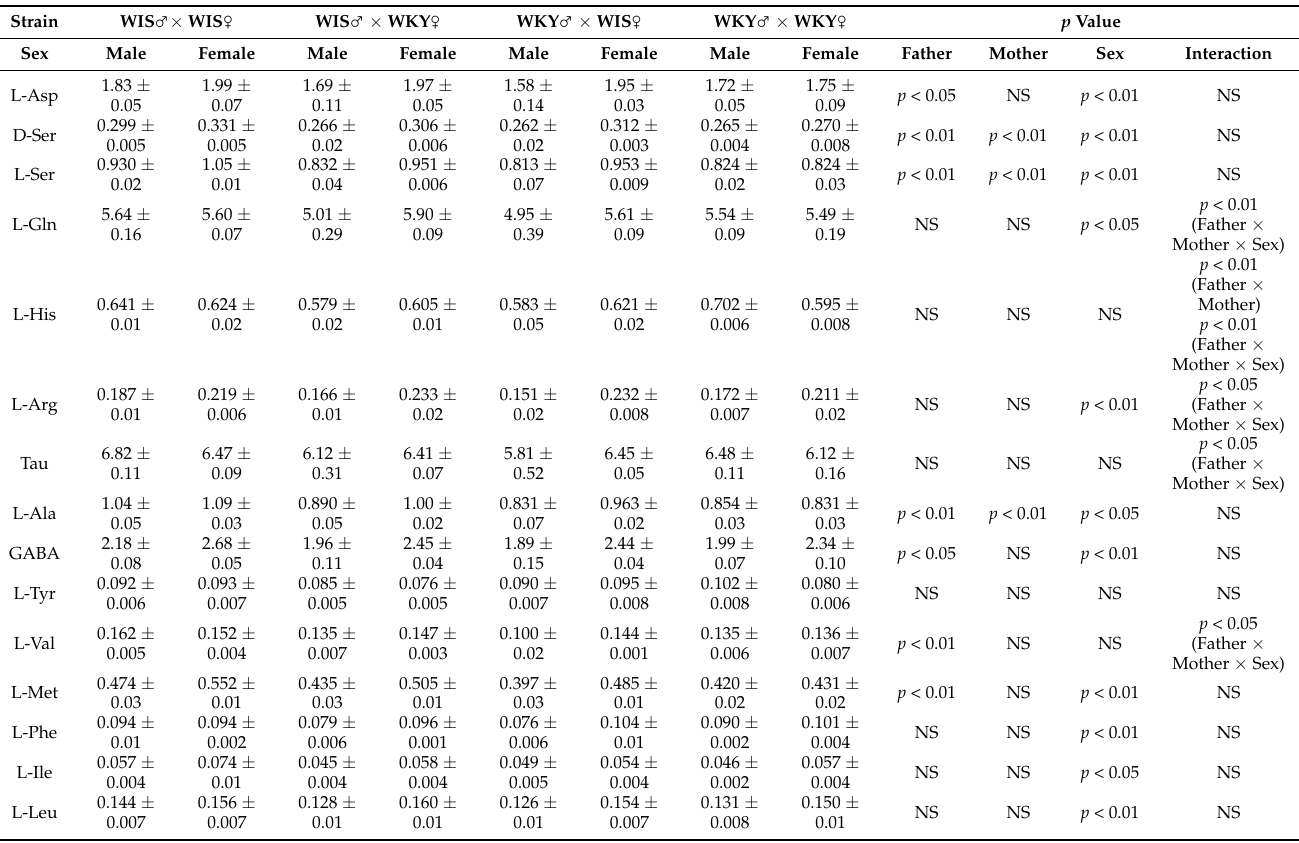
Table 2. Effect of paternal or maternal strain and sex of offspring on free amino acid concentration in the hippocampus.